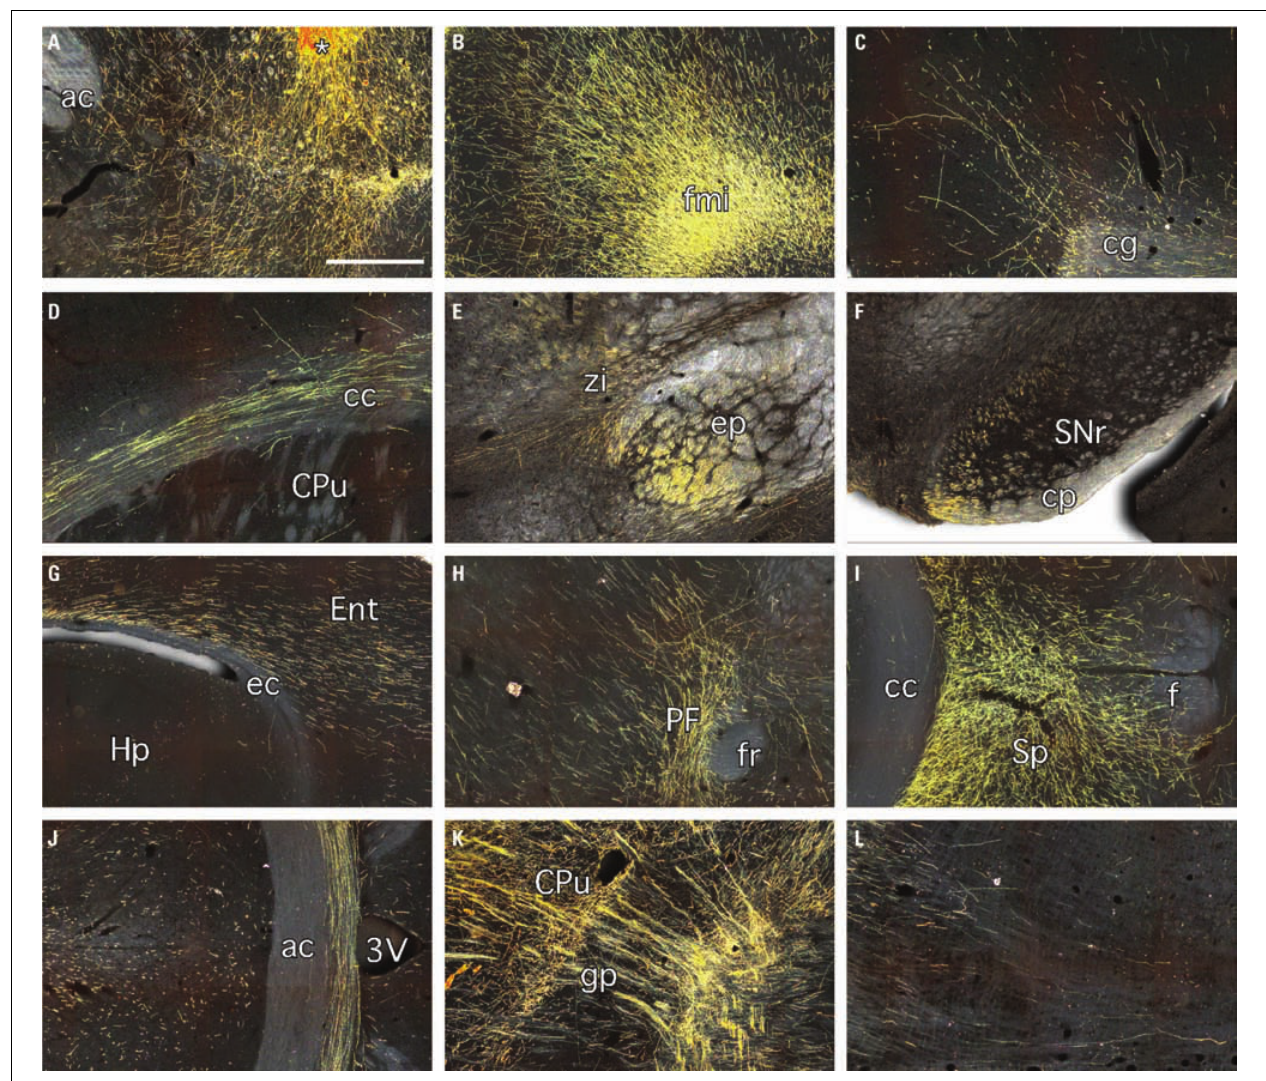
substantia nigra pars reticulata and the underlying cerebral peduncle; (G) exiting the caudal and ventral extremities of the external capsule into the adjacent entorhinal cortex; (H) at the level of the parafascicular thalamic nucleus; (I) in the septum; (J) running through the